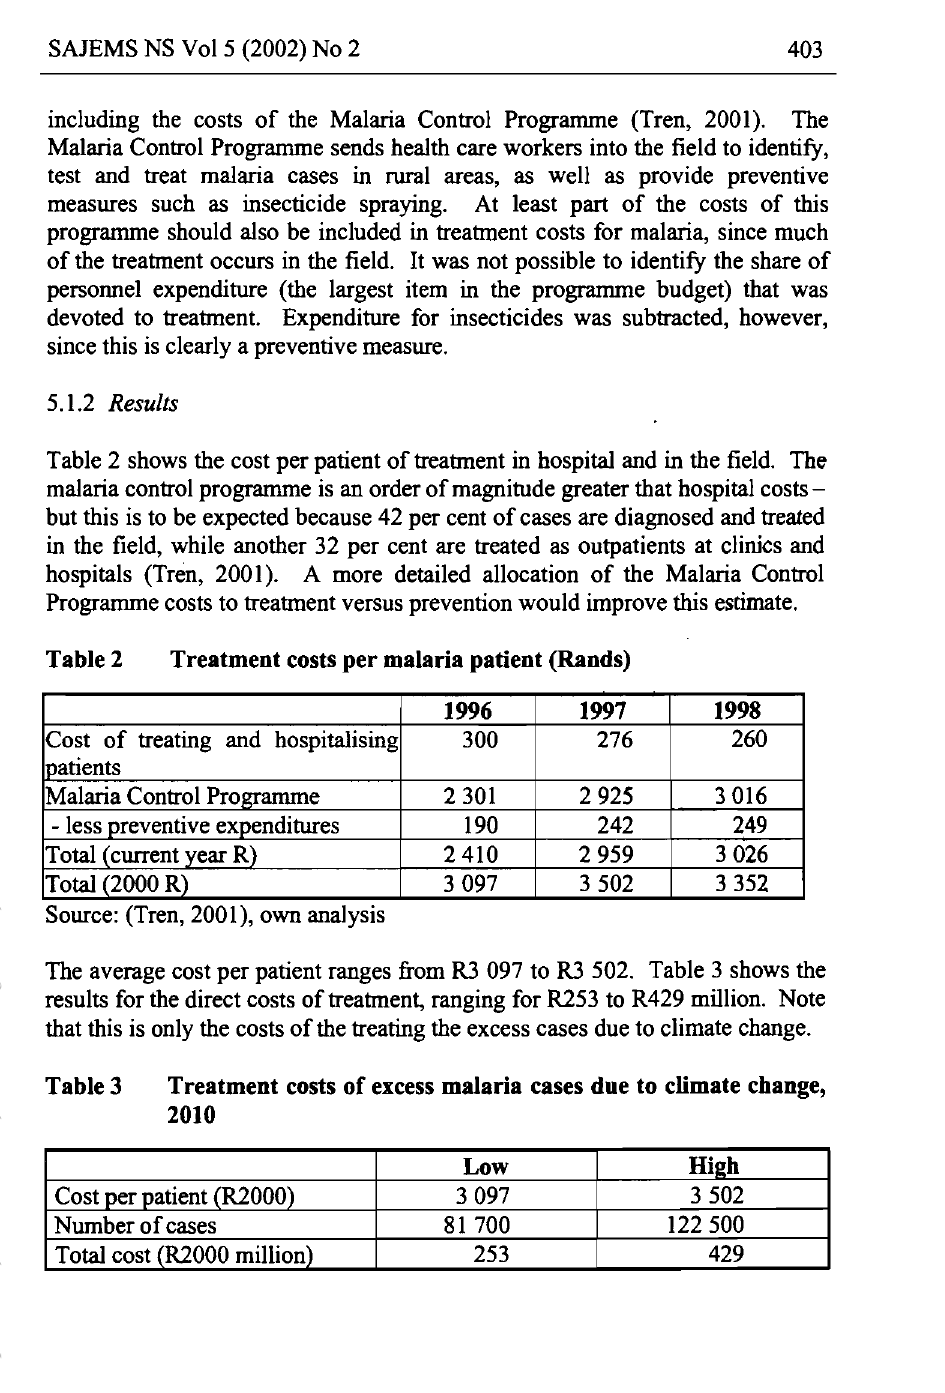
Treatment costs per malaria patient (Rands)